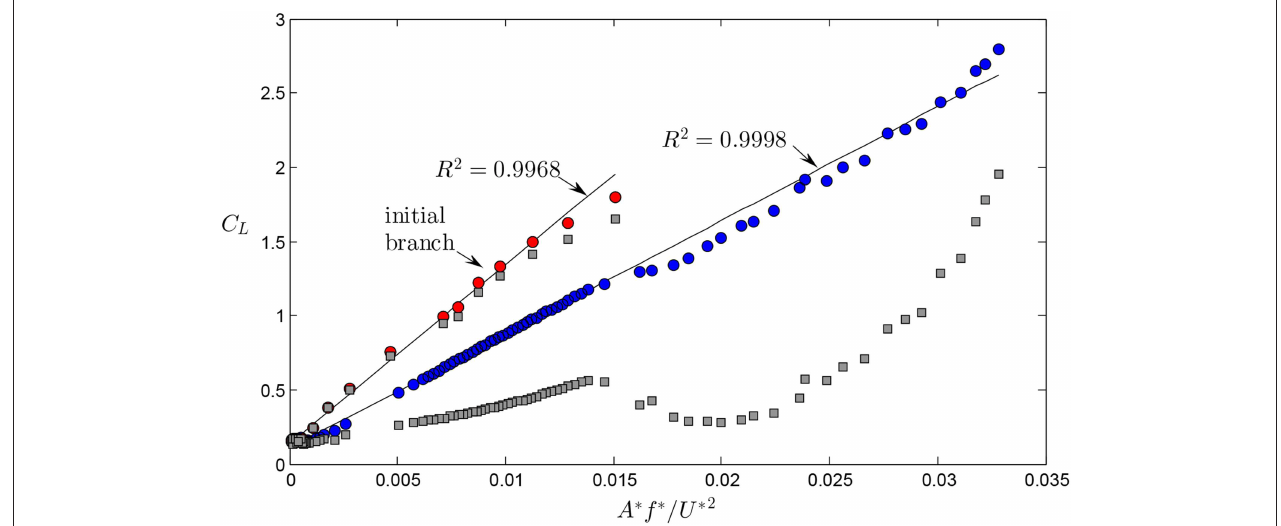
FIGURE 10 | Variation of the mean magnitude of the unsteady lift, C L , with the combined parameter A ∗ f ∗ / U ∗ 2 (circles). Red-filled circles correspond to data from the initial branch while blue-filled symbols correspond to all other branches. Square symbols show the variation of the magnitude of the transverse force, C y (see